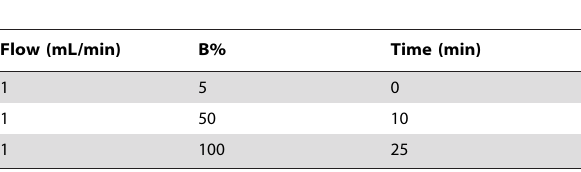
Table 1. The gradient program of HPLC mobile phase in profiling of phenolics